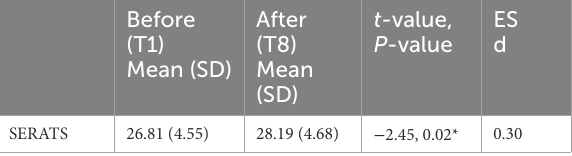
TABLE 2 Self-expression and emotional regulation in art therapy (SERATS) before and after the four sessions ( N =